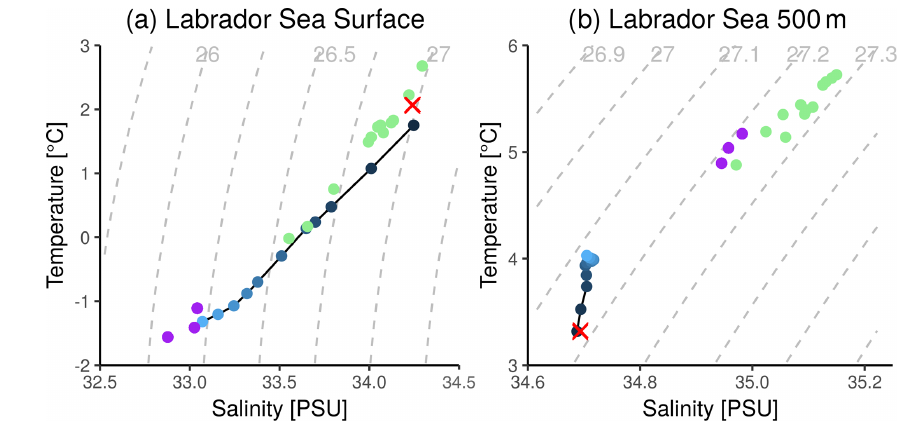
Figure 11. Scatter plot between the climatological Labrador Sea temperature and salinity during the convection season (February–March– April) both (a) at the surface and (b) at 500m. Blue dots of different intensity represent the climatological PRED values as a function of forecast year: the red cross represents RECON, and the green (purple) dots represent the HIST members with (without) active Labrador Sea convection. Isopycnals are represented by dashed grey lines in the